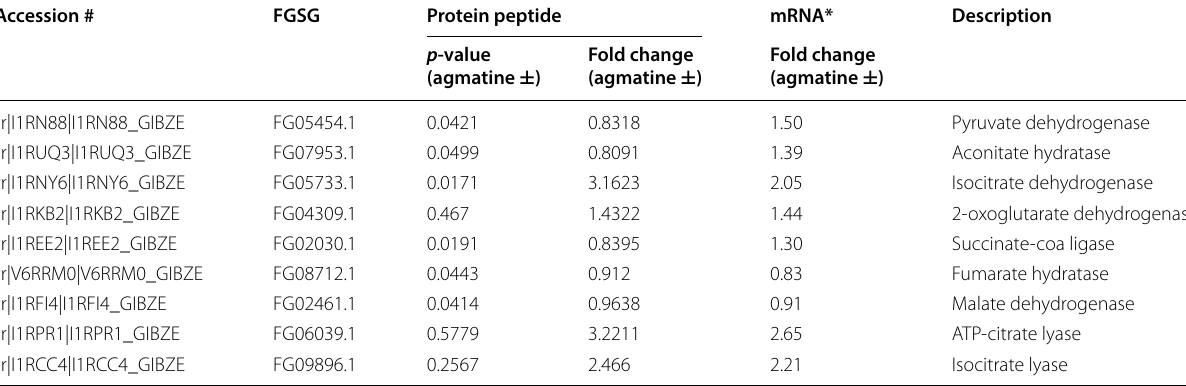
Protein peptides were detected using LC–MS/MS as described in the “Materials and methods” section. Accession # is the number in UniProt. Data marked with an asterisk (*) are quoted from Suzuki et al.